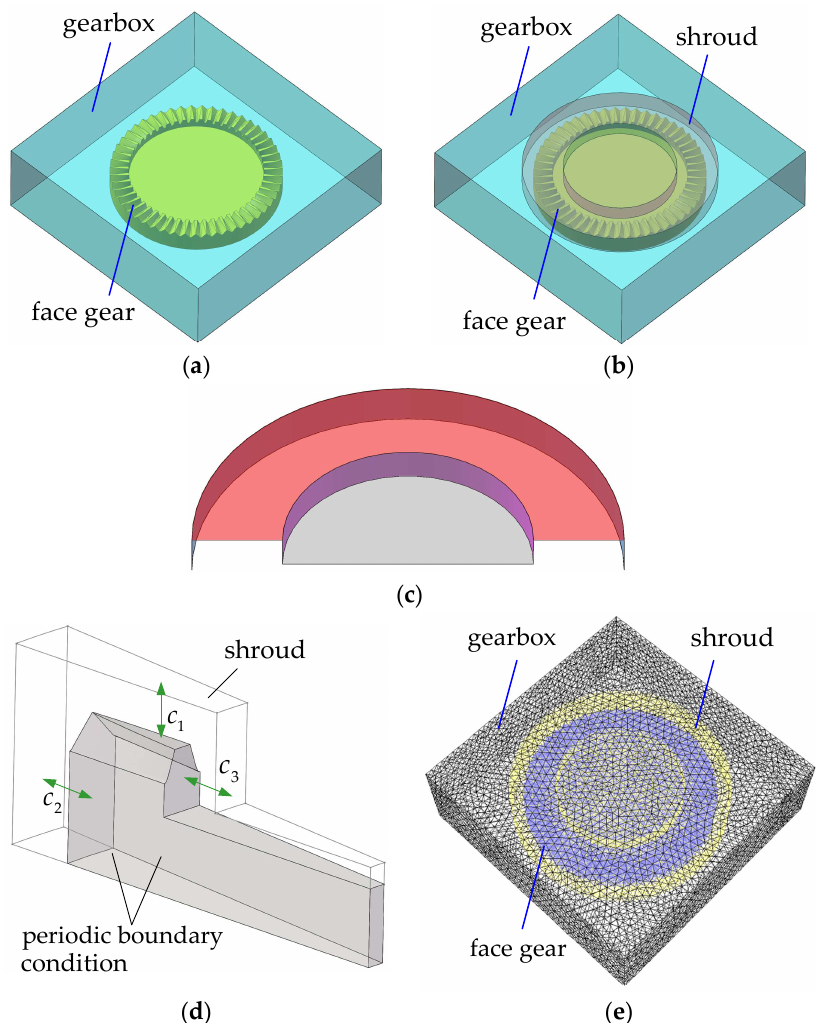
Figure 4. ( a ) Overall calculation CFD model without shroud; ( b ) overall calculation CFD model with shroud; ( c ) cross-section of the shroud; ( d ) PBC calculation CFD model; and ( e ) mesh model with shroud.